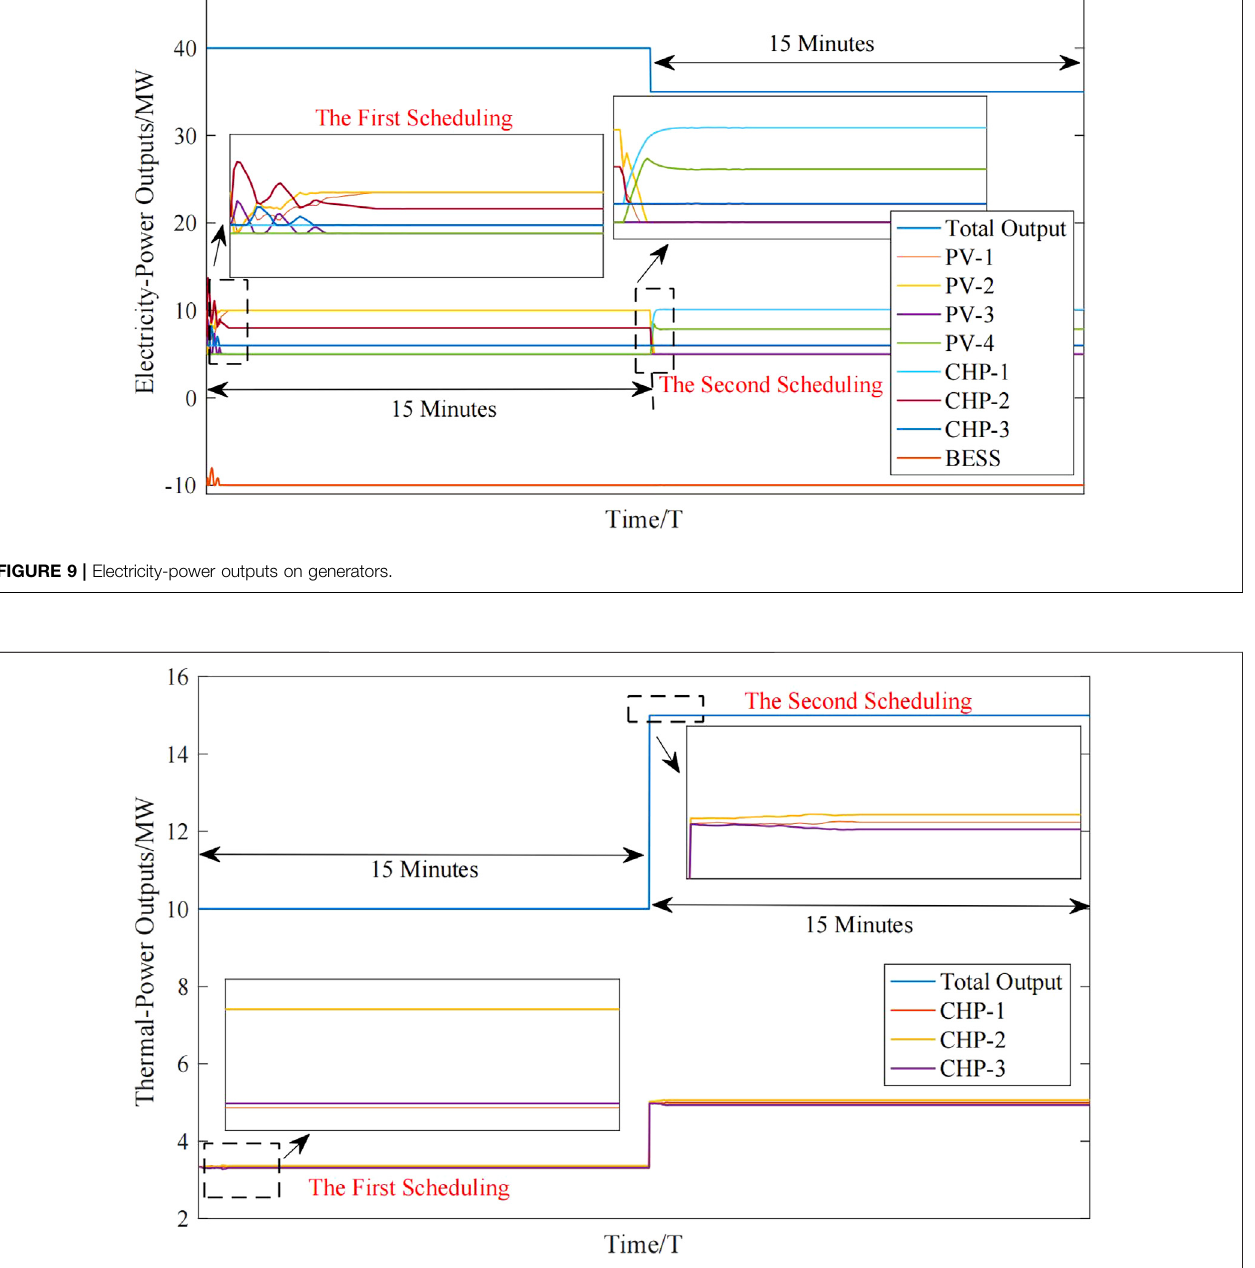
FIGURE 10 | Thermal-power outputs on